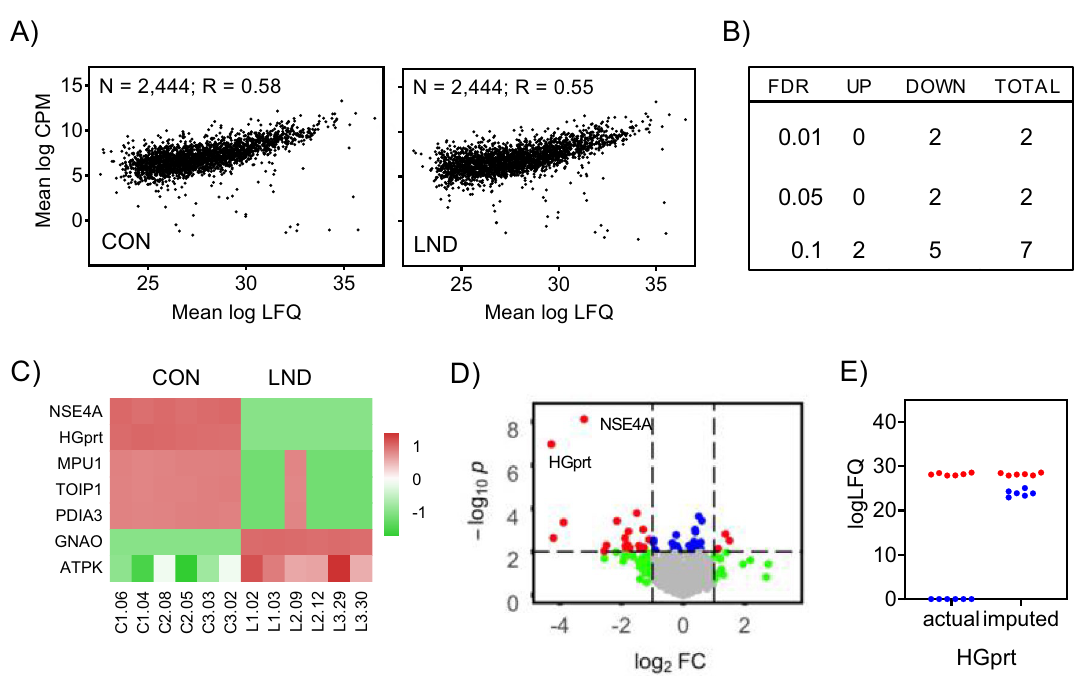
Figure 4. Proteomics analysis. Protein expression profiles were evaluated by shotgun proteomics for all LND (n = 6) and control (n = 6) lines. There was a good quantitative correlation between the gene and protein expression results for both the LND and control lines ( A ). Only 7 proteins reached statistical thresholds for differential expression at FDR < 0.10 ( B ). Individual variation for among the lines for the 7 proteins meeting the FDR < 0.10 criterion is shown as a heatmap ( C ). Red depicts a higher gene expression and green depicts lower gene expression. Only 2 proteins remained significantly different between LND and control at FDR < 0.01, and a volcano plot revealed marked reductions in the levels of both HGprt and NSE4A ( D ). Red depicts genes with p < 0.001 and fold change > 2. Green and gray depict FDR > 0.05. The marked reductions in all LND lines (blue) compared to all control lines (red) were confirmed by evaluation of the raw and imputed values for HGprt ( E